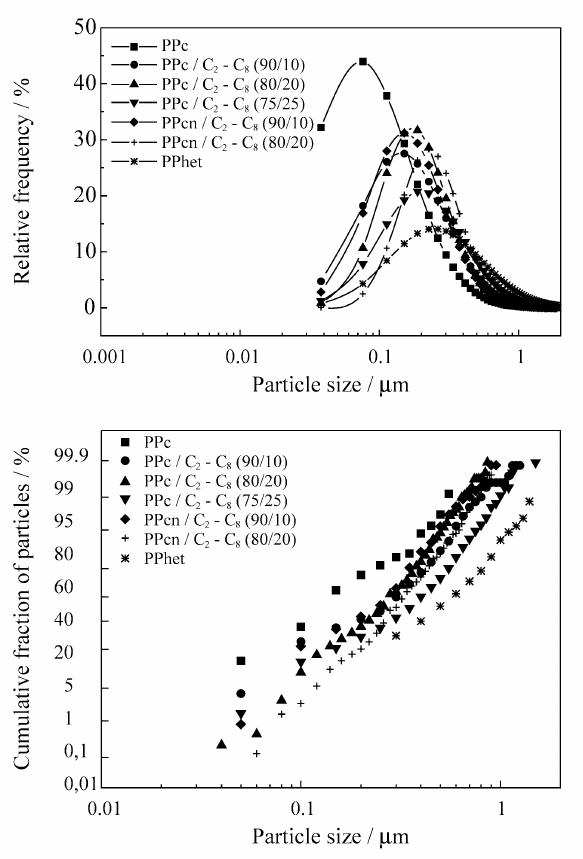
Figure 7. Best fitting lognormal curves of the particle size distribution in terms of a) relative frequency for all samples and b) as cumulative fraction of the